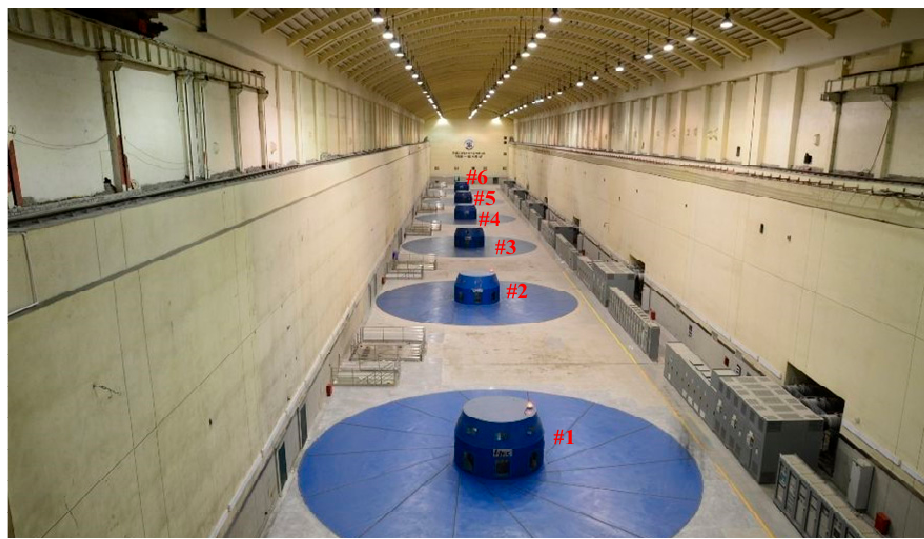
Figure 2. Main powerhouse of the hydropower station in Yalong River.